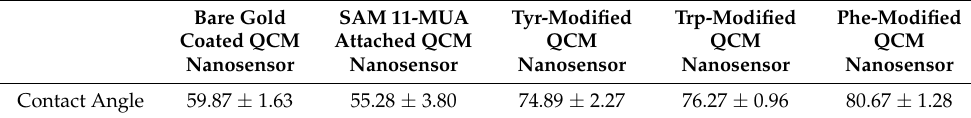
Figure 4. ATR-FTIR spectra of surface modified QCM nanosensor with 11-MUA (( a )-upper) and 11-MUA molecules (( a )-bottom) and 11-MUA-Tyr, 11-MUA Trp and 11-MUA-Phe (( b )-from top to bottom). Table 2. Contact angle ( θ ) measurements of the bare and modified QCM